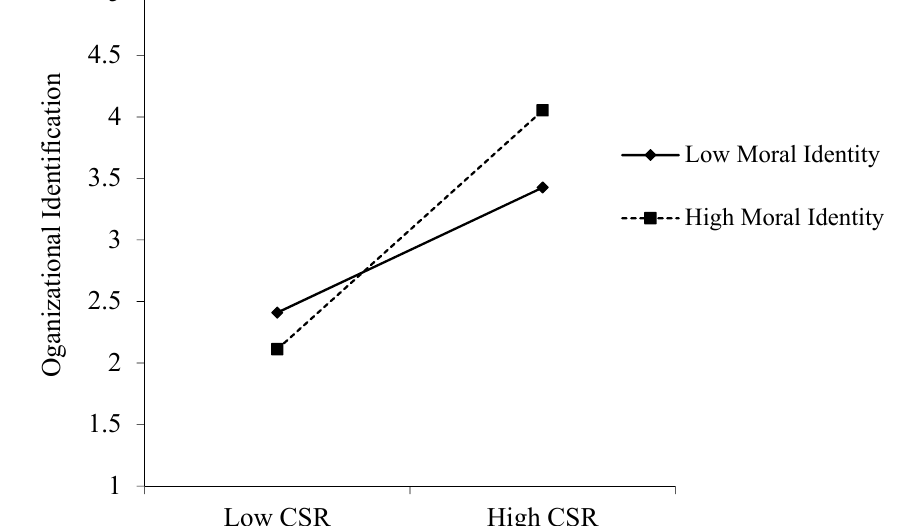
Figure 3. Moderating Effect of Moral Identity in the CSR-OI Link .